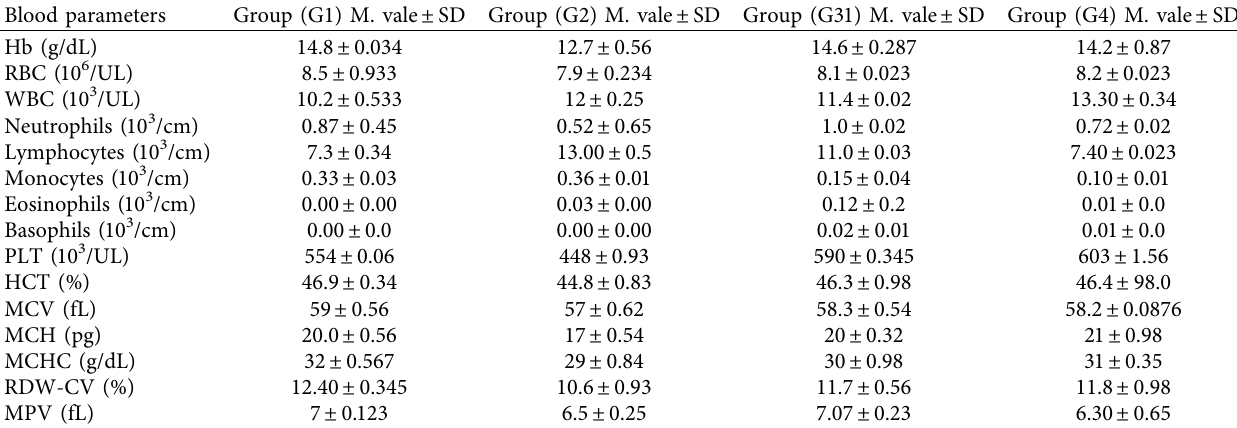
Table 7: Infected rats’ whole blood picture following treatment with A. herb Alba TiO2 NPs and antibiotics. Blood parameters